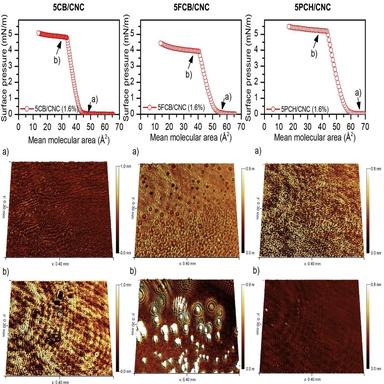
The surface pressure (π)-Mean molecular area (A) isotherms for 5CB/CNC (left column), 5FCB/CNC (central column), and 5PCH/CNC (right column) with corresponding 3D BAM images of uncompressed (a) and compressed (b) monolayer.